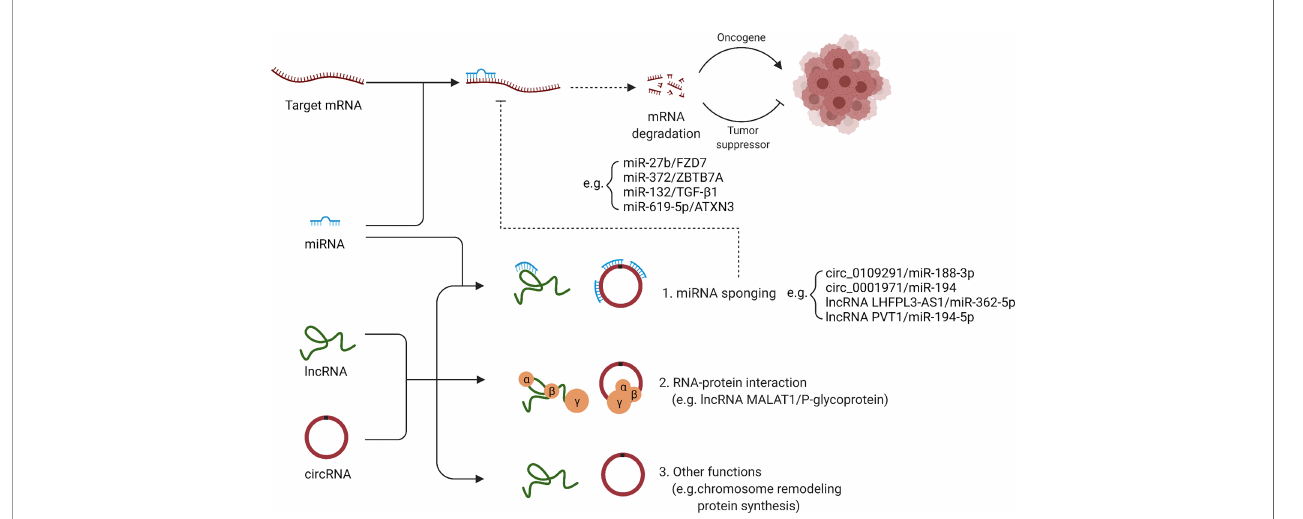
FIGURE 2 | Regulation of cisplatin resistance by ncRNAs: a molecular mechanism. LncRNAs and circRNAs can function as sponges for miRNAs, and thus affect the regulatory role of miRNAs on target genes. In addition, lncRNAs and circRNAs can also interact with proteins, remodel chromosome structure and affect protein